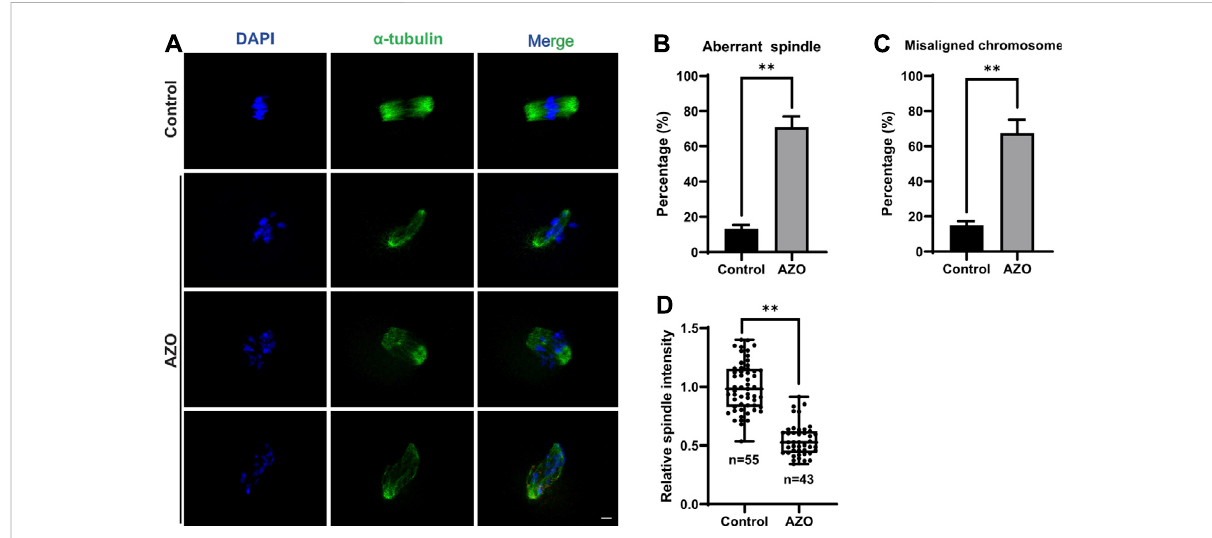
FIGURE 2 AZO treatment impairs alignment of chromosomes and organization of spindles in oocytes. (A) Representative images showing spindle morphologiesandchromosomealignmentinAZO-treatedoocytesandcontroloocytes.TheMIstageoocyteswerestainedwith α -Tubulinantibody and DAPI to visualize spindle and chromosomes, respectively. Scale bar, 10 μ m. (B) The aberrant spindle rate was evident in the control and AZO- treated oocytes at MI stage. (C) The aberrant misaligned chromosome was evident in control and AZO-treated oocytes at MI stage. (D) Quanti fi cation of spindle intensity in control and AZO-treated oocytes at MI stage. Data are expressed as mean ± SEM. ** p < 0.01.